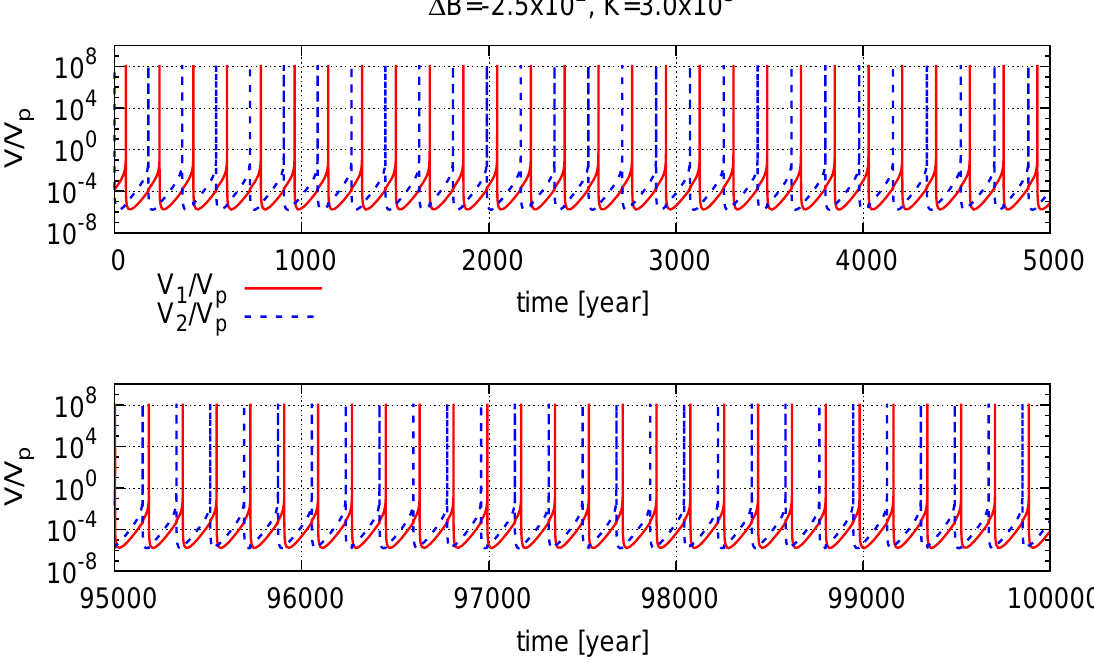
Fig. 6. The time evolution of V/V p for case 1 in a logarithmic scale. The variation from 5000 to 95000yr is not shown. The parameters are B = 2 . 20 × 10 5 Nm − 2 for oscillator 1, B = 2 . 2025 × 10 5 Nm − 2 for oscillator 2, and K = 3 × 10 3 Nm − 3 . The oscillators synchronize at a phase difference of ψ = − 1 .